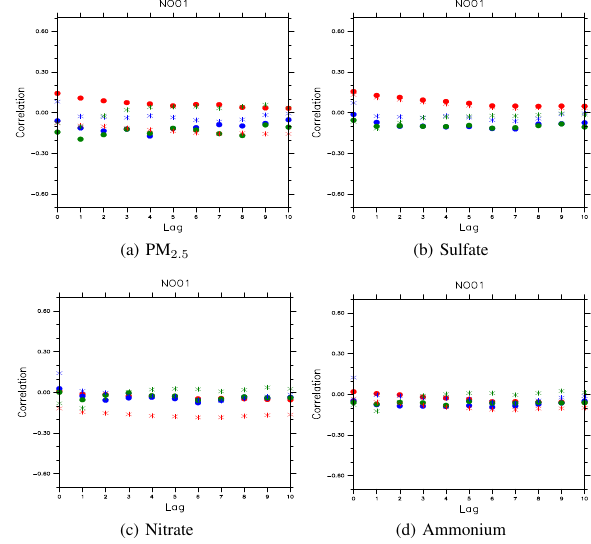
Fig. 8. Correlations between meteorology (temperature in red, pre- Fig. 8 : Correlations between meteorology (temperature in red, precipitation in blue, wind speed cipitation in blue, wind speed in green) on a given day and pollutant in green) on a given day and pollutant concentrations (PM 2 . 5 , sulfate, nitrate and ammonium), concentrations (PM 2 . 5 , sulfate, nitrate, and ammonium), ranging up ranging up to 10 days after at IT01 (2007-2008). Simulated data are represented with a star, to 10 days after at IT01 (2007–2008). Simulated data are repre- while observational data are represented with a dot. sented with a star, while observational data are represented with a dot.